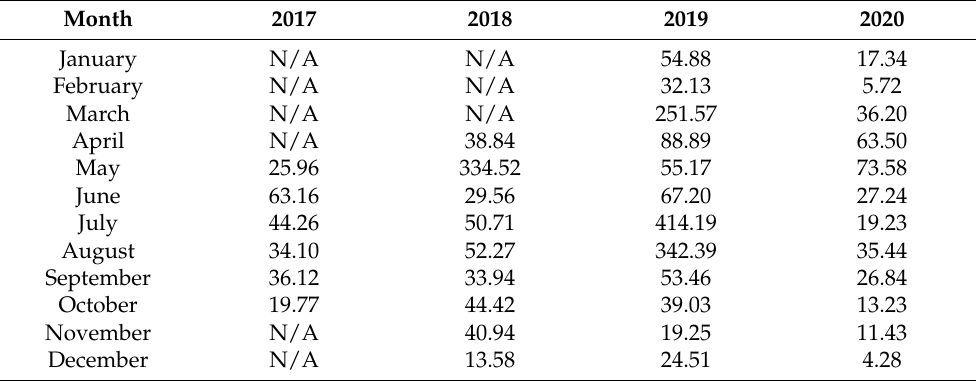
Table 6. Monthly average of weekly DIN AD (mg/m 2 /week) 1 .